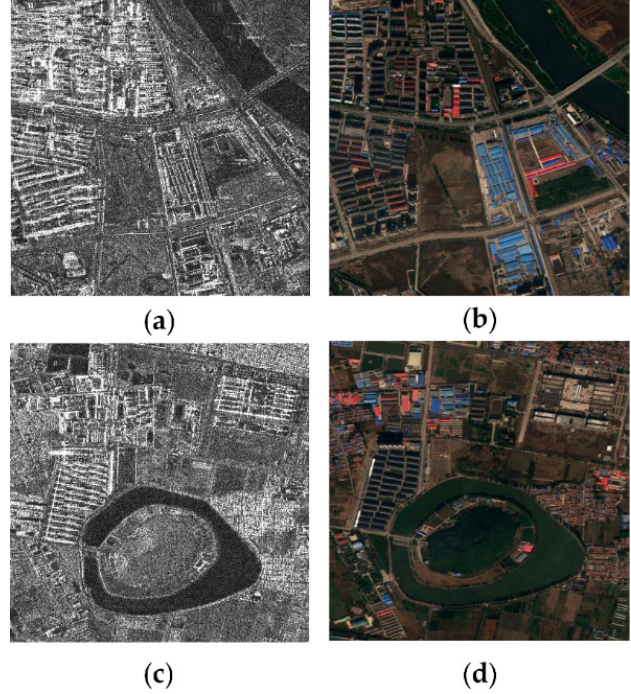
Figure 7. Two time-series datasets of TerraSAR-X remote sensing images in Tongzhou District of Beijing: ( a ) Dataset 1 (first scene); ( b ) Optical image; ( c ) Dataset 2 (1st scene); ( d ) Optical image.